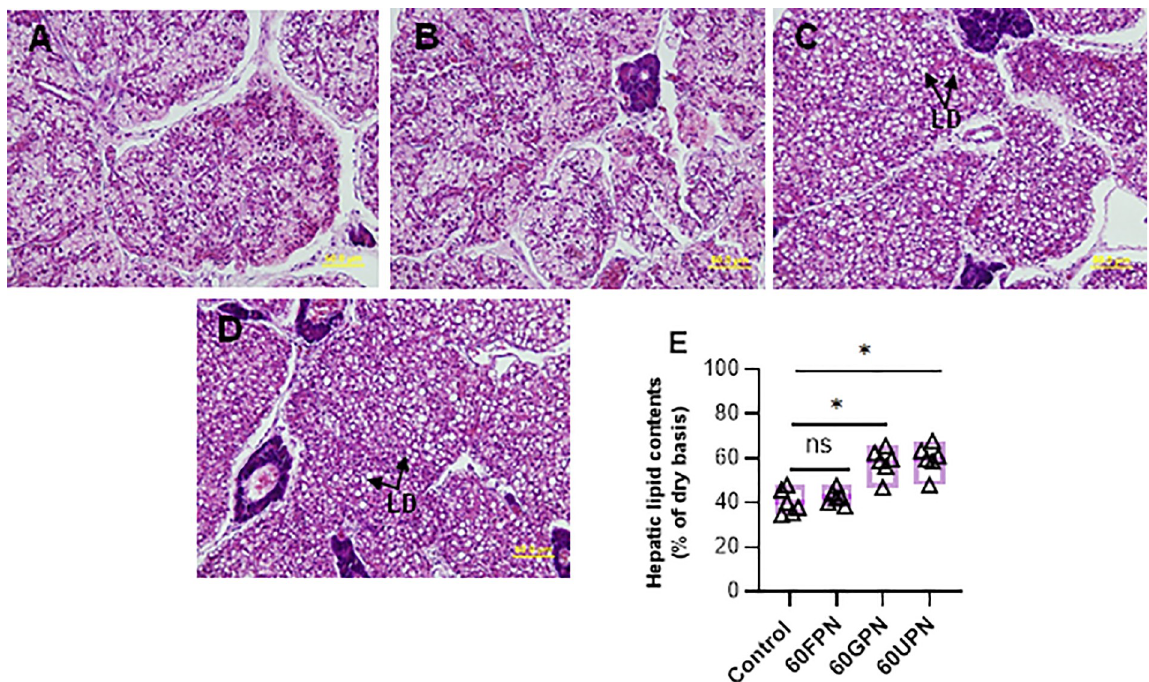
Fig 2. Histological structure of the liver of juvenile barramundi fed control, 60FPN, 60GPN and 60UPN diets (A-D, respectively). Black arrow in liver micrographs indicates large vacuoles in hepatic cells (H&E staining, 40 x magnification, scalebar = 50 μ m). Variation in the hepatic lipid content in fish fed control, 60FPM, 60GPM and 60UPM after 8 weeks (E). Significant at � P < 0.01 (one-way ANOVA with Dunnetts multiple comparisons test). ns: not significant.